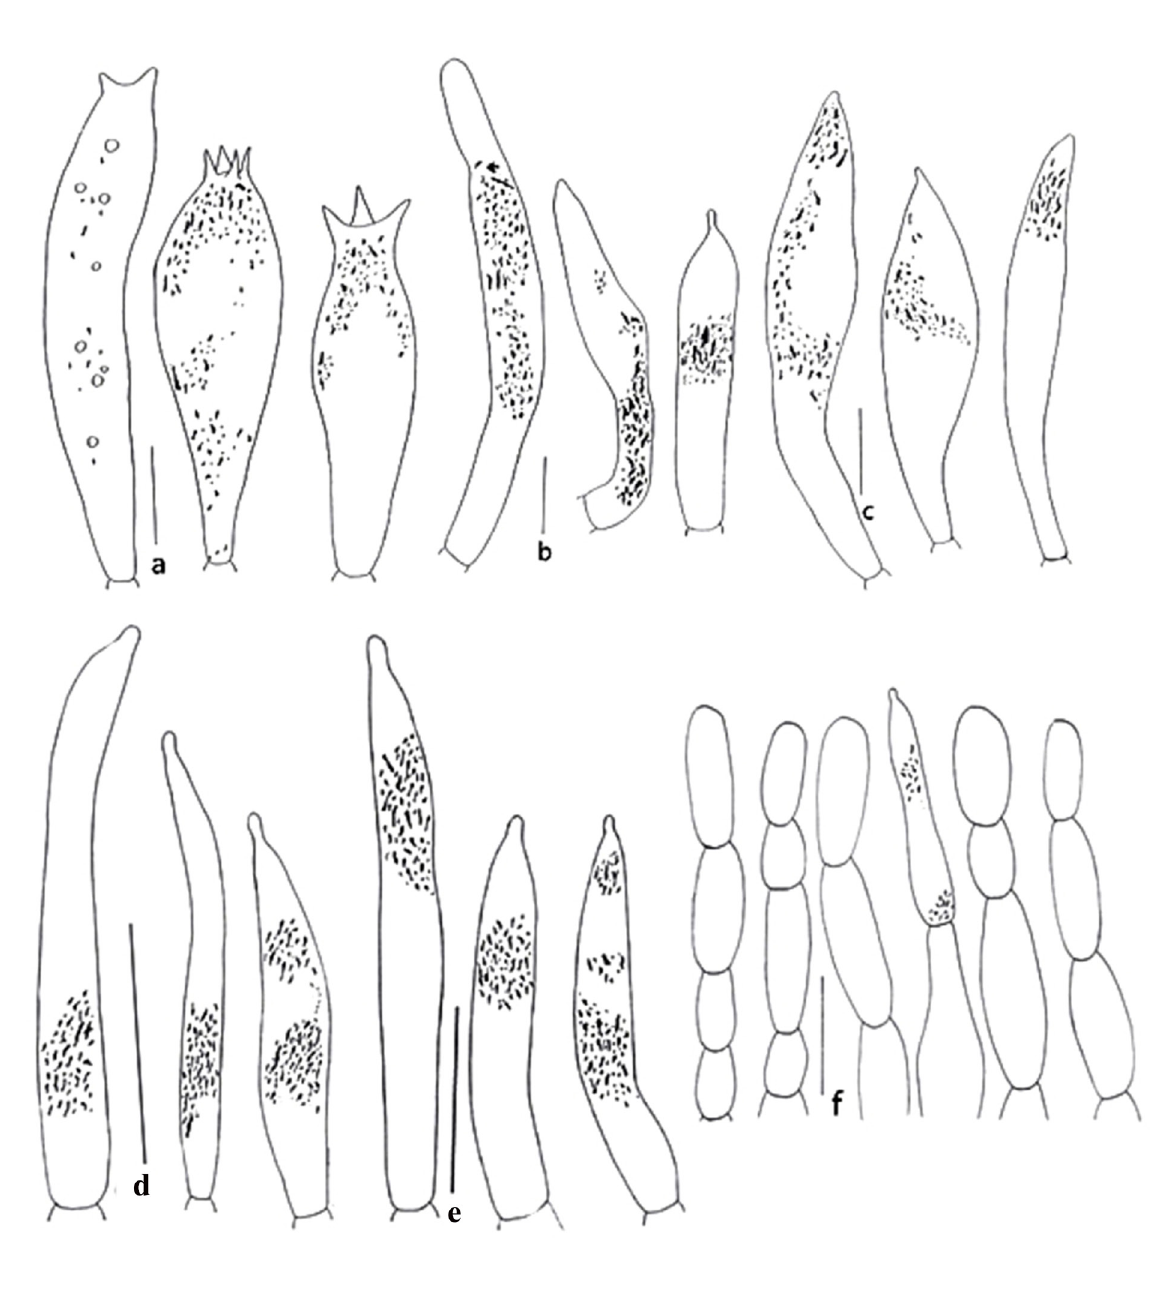
Fig. 3. Russula fusiformata Y.Song sp. nov., holotype (GDGM75333). a . Basidia. b . Pleurocystidia. c . Cheilocystidia. d . Pileocystidia. e . Caulocystidia. f . Pileipellis. Scale bars = 10